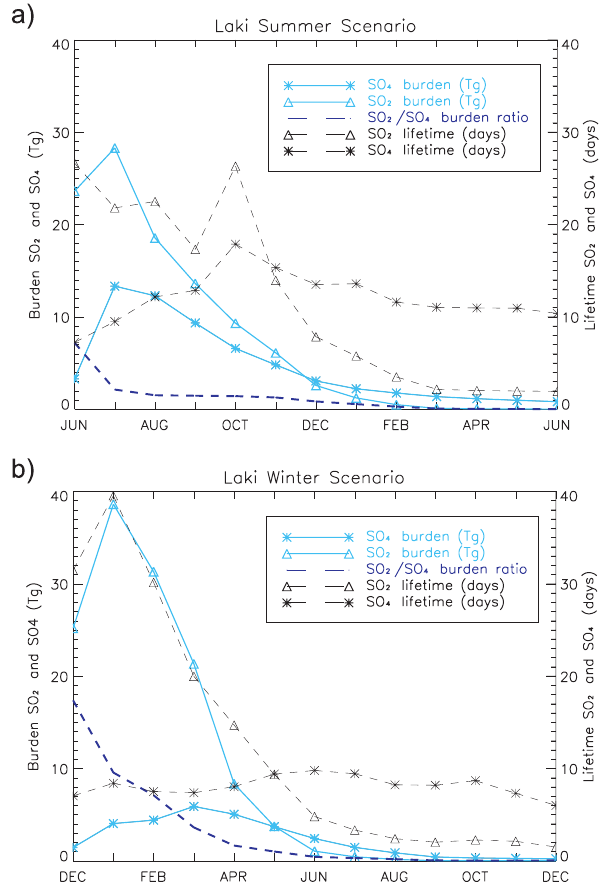
Fig. 3. Simulated global monthly mean SO 2 burden (solid, light blue line with triangles) and SO 4 burden (solid, light blue line with asterisks), SO 2 to SO 4 ratio (dashed dark blue line), and SO 2 resi- dence time (dashed black line with triangles) and SO 4 aerosol res- idence time (dashed black line with asterisks) for L-s (a) and L- w (b) ,